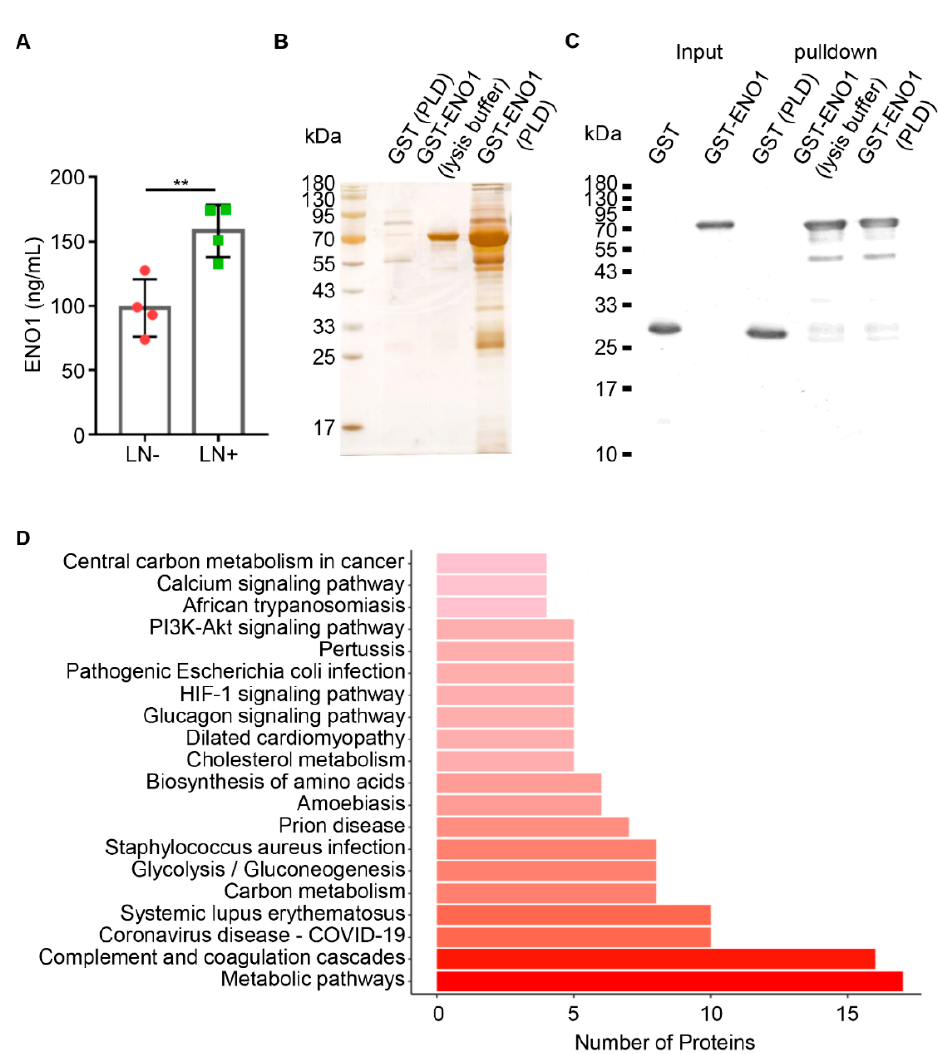
Figure 2. ENO1 directly bound to ApoC3 in postoperative lymphatic drainage (PLD) of metastatic OSCC. ( A ) Quantitative analysis of ENO1 expression in PLD between non-metastatic (left) and metastatic (right) OSCC patients. ( B ) The SDS-PAGE for the GST pulldown product shown by silver staining. ( C ) Western blot analysis using an anti-GST antibody for the GST pulldown product. ( D ) Distribution of the top 20 KEGG pathways based on ENO1-interacting proteins in PLD of metastatic OSCC. Columns refer to related pathways, which are colored with gradient colors from midnight red (metabolic pathways) to lighter red (central carbon metabolism in cancer). ** p <